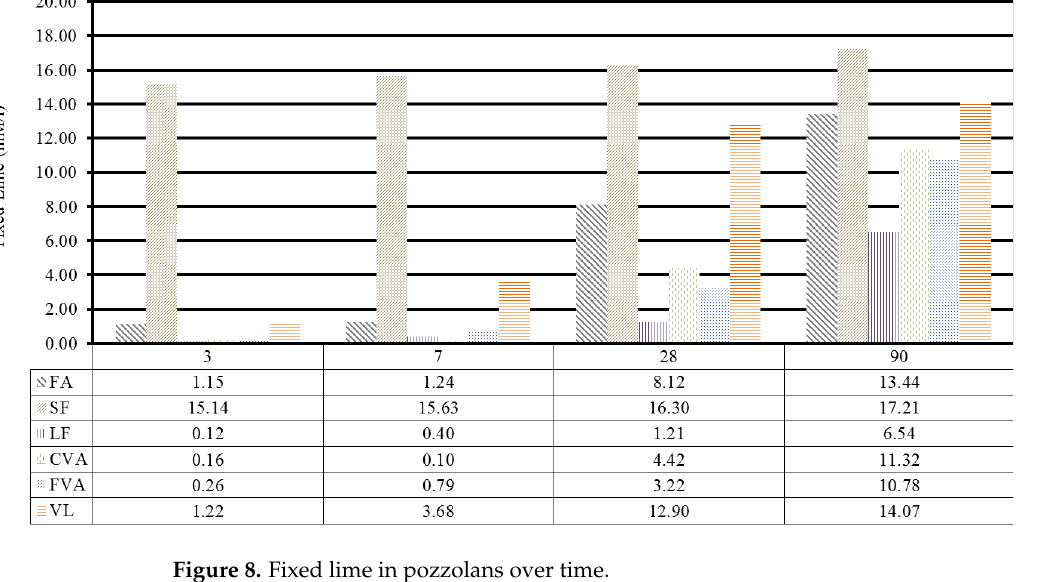
Figure 8. Fixed lime in pozzolans over time.